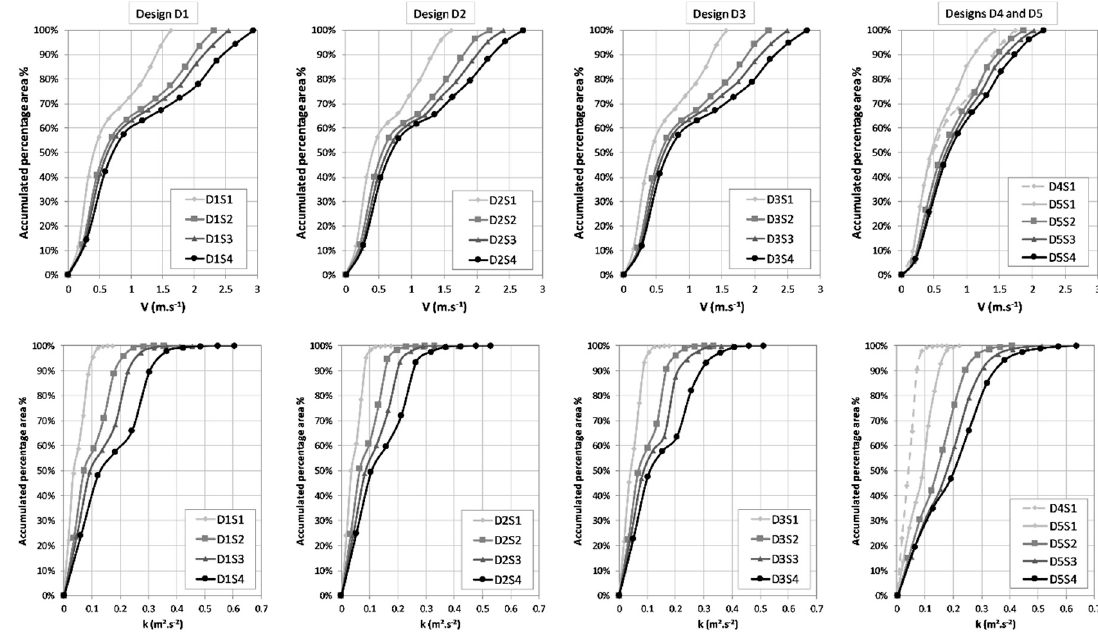
Figure 9. Cumulative frequency distribution curves of velocities (V) and turbulence kinetic energy (k) on a horizontal plane at z/h = 0.4 for different geometries, slopes and discharges. For design D1, the discharges correspond to the mean flow depth of 1.3 m. For the other designs, the same discharges of D1 were used for the correspondent slopes.